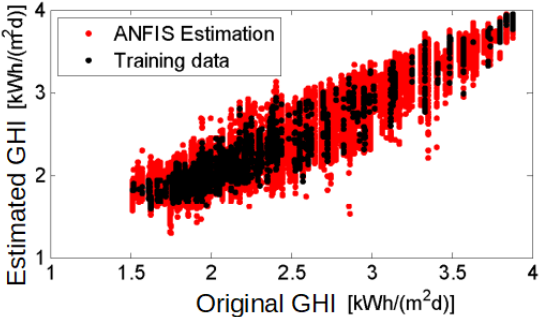
Figure 10. Correlation between 100 km 2 radiation data and 1 km 2 resolution estimated radiation.